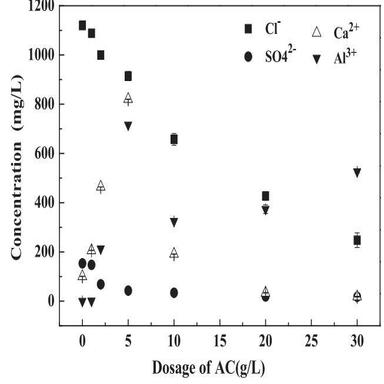
Components of landfill leachate after treated by different dosage of AC and Ca (OH)2.